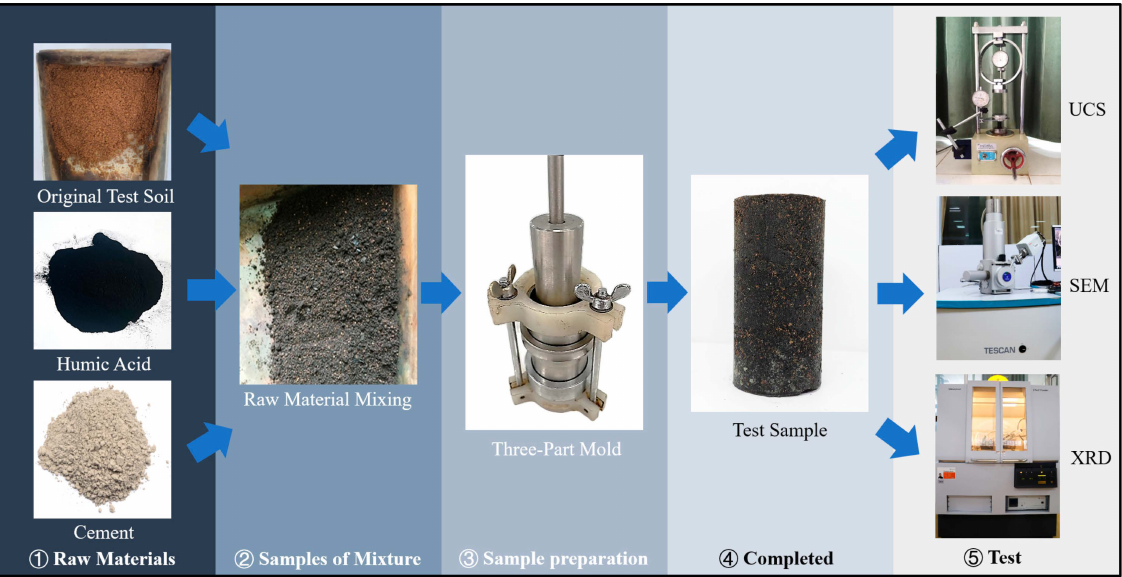
Figure 6. Sample preparation